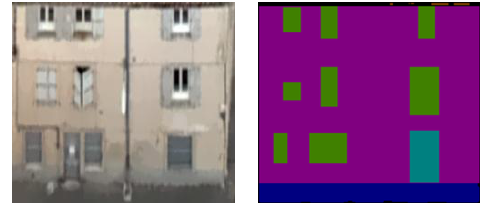
Figure 13: Precision errors on the position and size of the openings